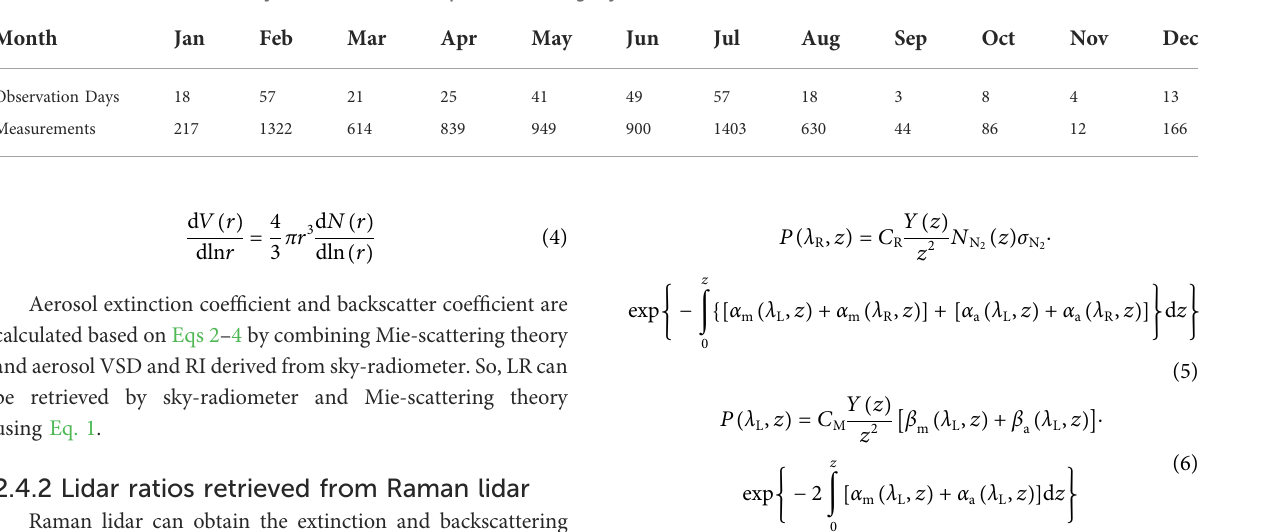
TABLE 1 Effective observation days and measurements per month using sky-radiometer in Xi ’ an.